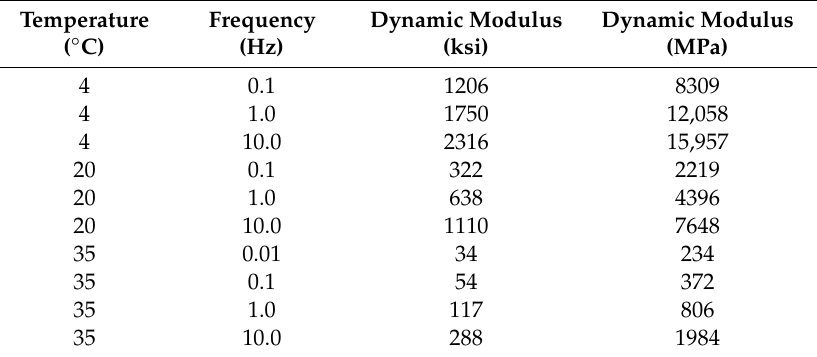
Table 2: Table 2. Average raw dynamic moduli of S (100) PG 64-22